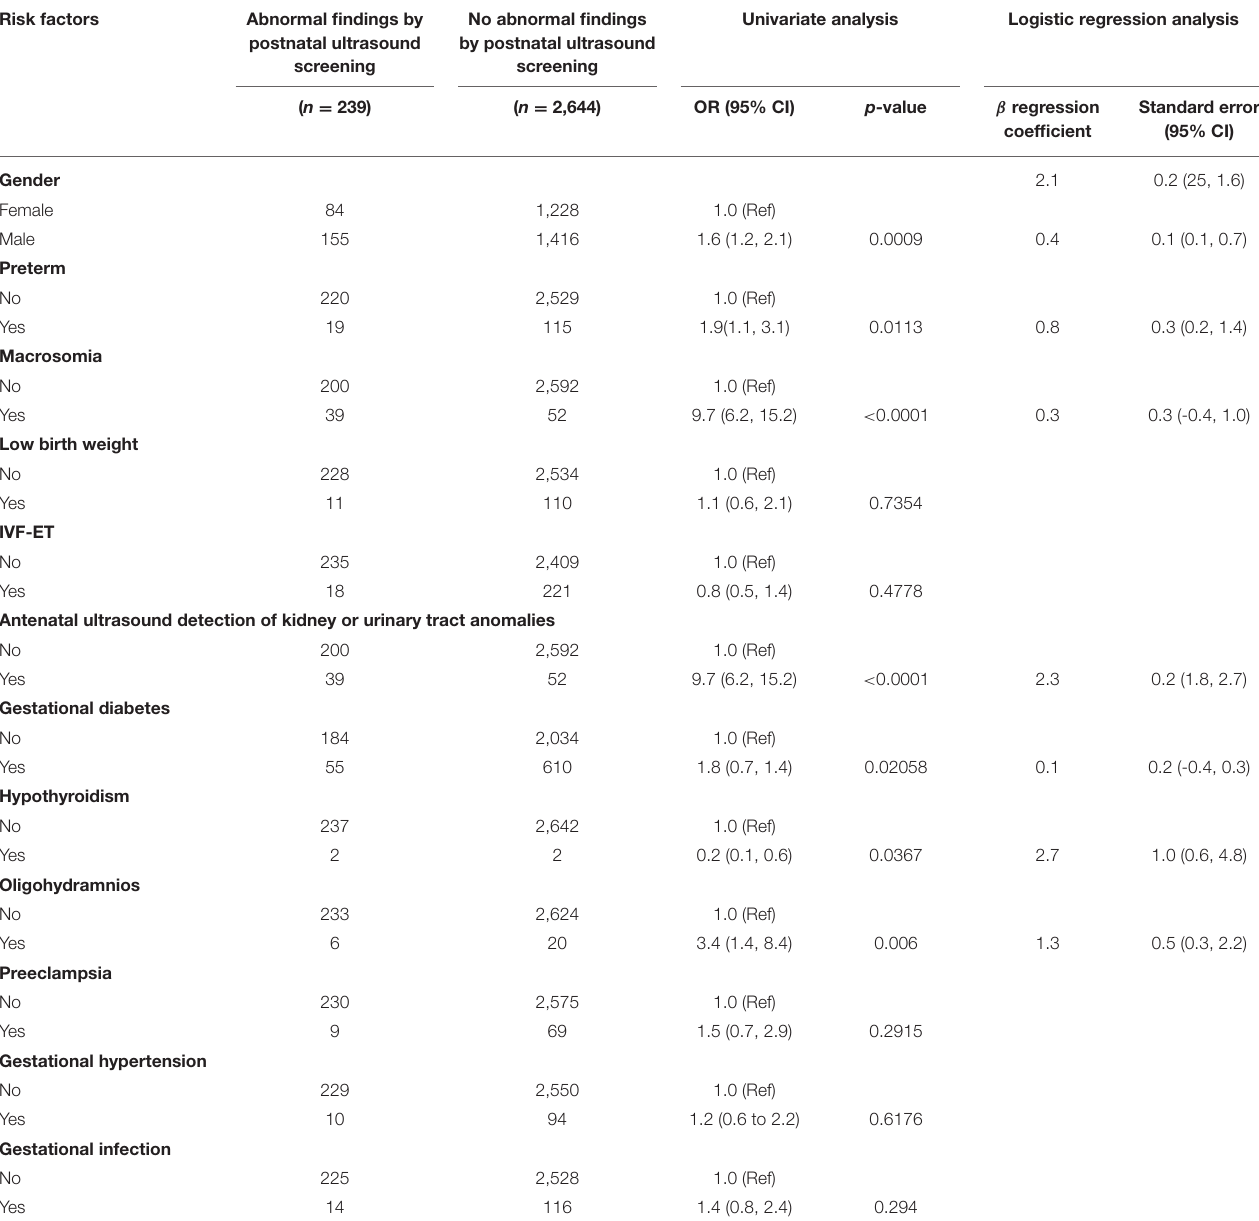
TABLE 2 | Univariate and multivariate logistic regression analysis of potential risk factors associated with kidney and urinary tract anomalies in 2,883 participants screened by postnatal ultrasound scanning. Risk factors Abnormal findings by postnatal ultrasound